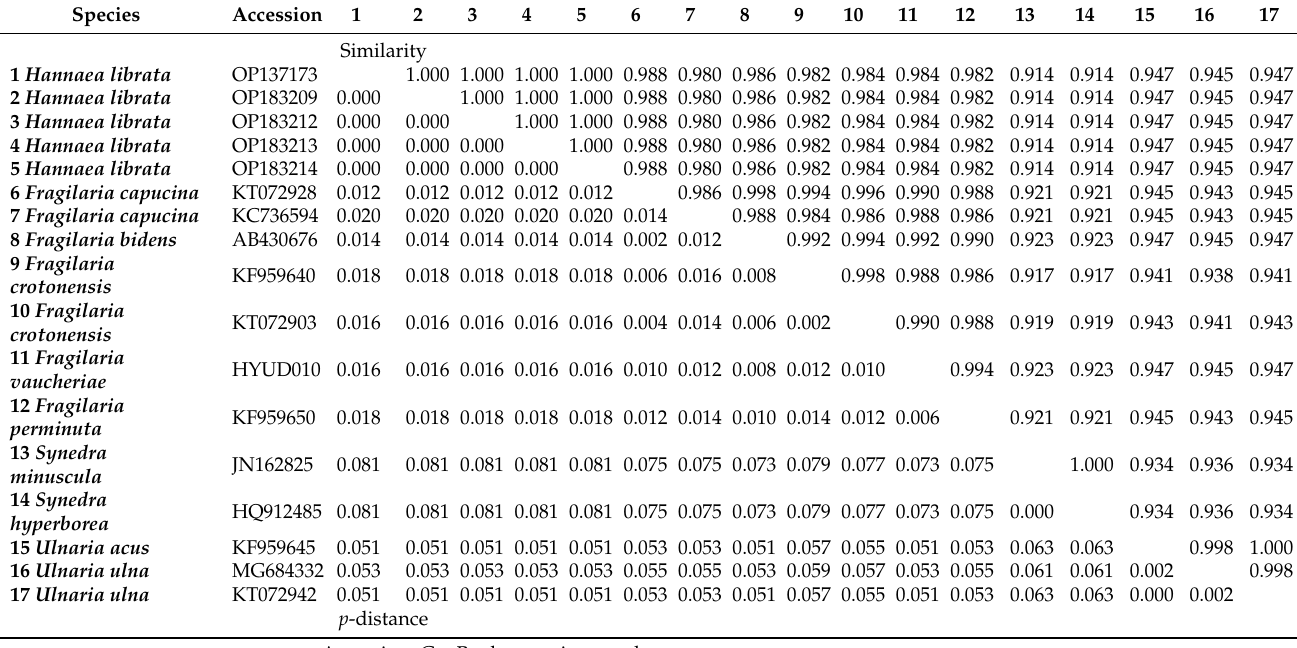
Table 4. Similarity scores and genetic distances among 17 aligned sequences (596 bp) based on rbcL gene.